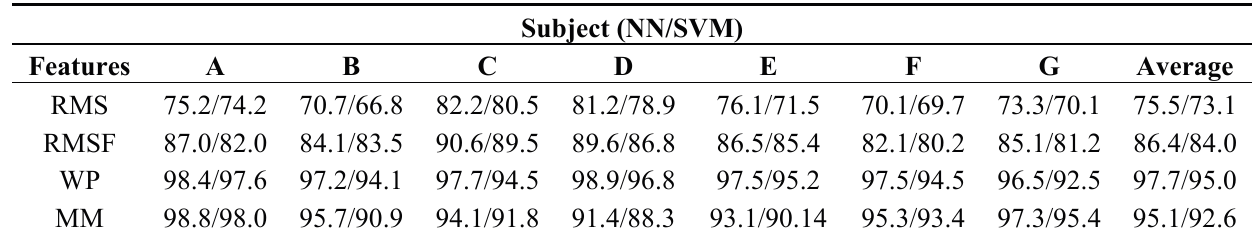
Table 2. Performance of off-line training. The value is the recognition accuracy rate defined by number of corrected recognized results dividing total results, with unit of